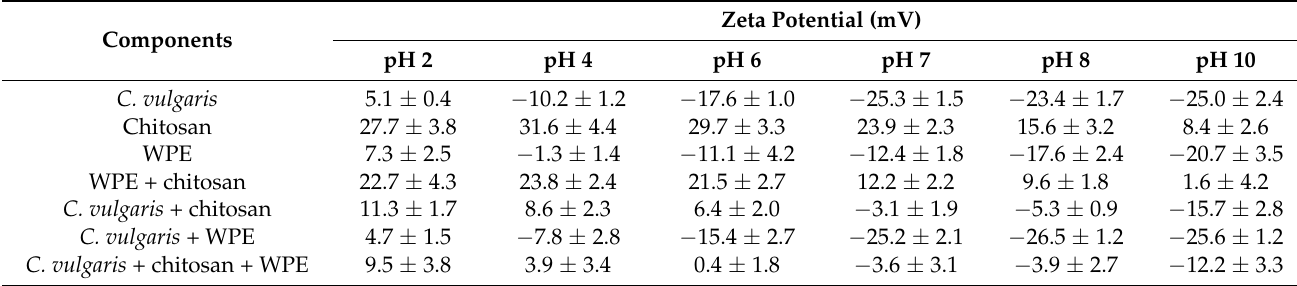
Table 1. The effect of pH on the zeta potential of C. vulgaris , chitosan, WPE, and their flocs. The data are shown as the mean ± standard error ( n = 3).